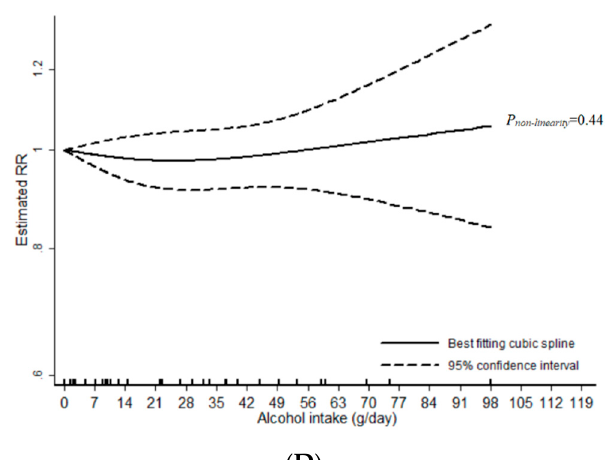
Figure 2. Meta-analyses of total alcohol intake and prostate cancer (PCa) risk: ( A ) linear analysis with non-aggressive PCa; ( B ) non-linear analysis with non-aggressive PCa; ( C ) linear analysis with aggressive PCa; ( D ) non-linear analysis with aggressive PCa. Abbreviations: PCa, prostate cancer; RR, relative risk; CI, confidence interval.